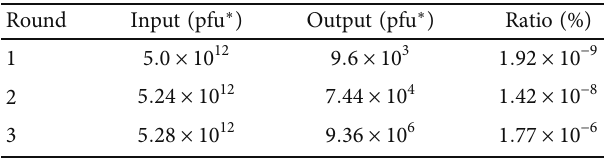
Table 2: Phages were applied and eluted in each round of panning by phage display.